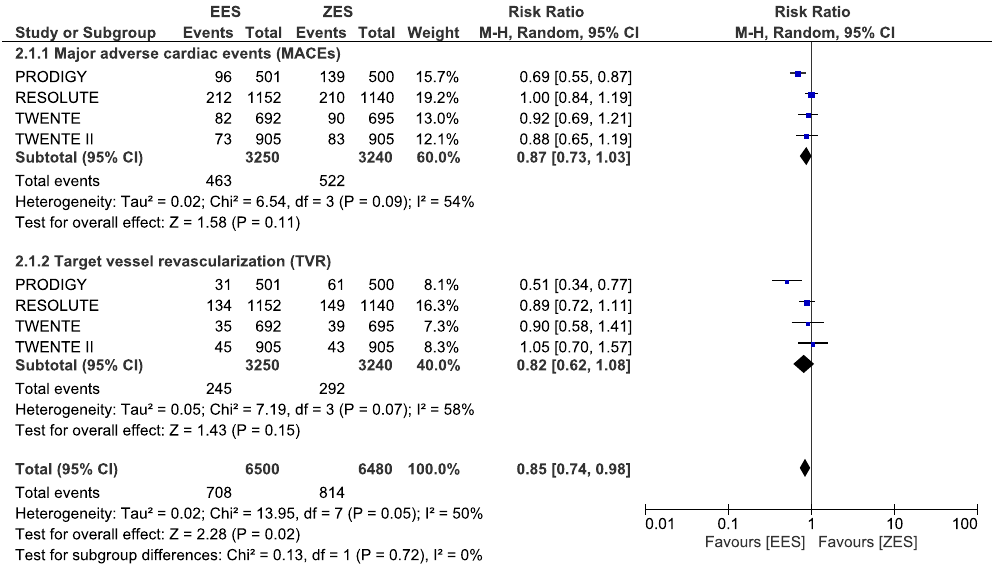
Figure 14. Long-term adverse outcomes which were observed with ZES versus EES (part 2).